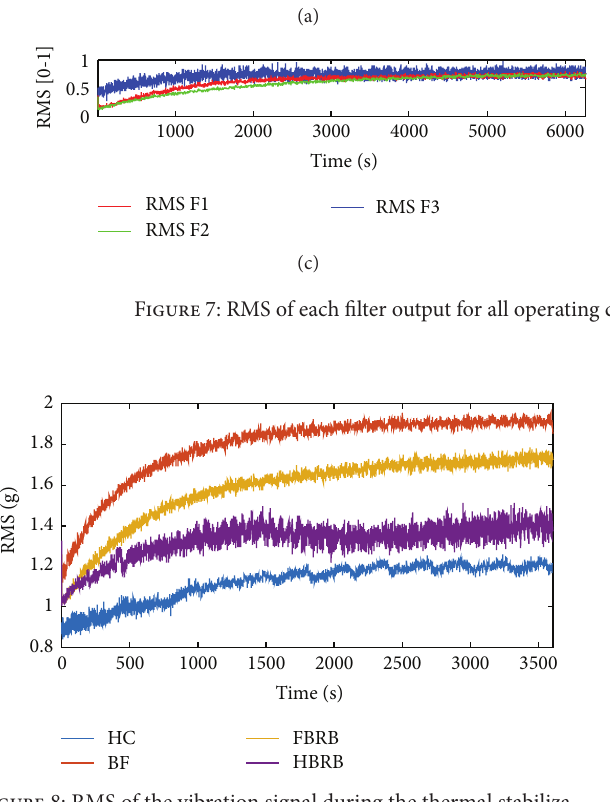
Figure 8: RMS of the vibration signal during the thermal stabiliza- tion period. Note that the different failures can be identified during this period, and as it was expected, the BF case shows the highest